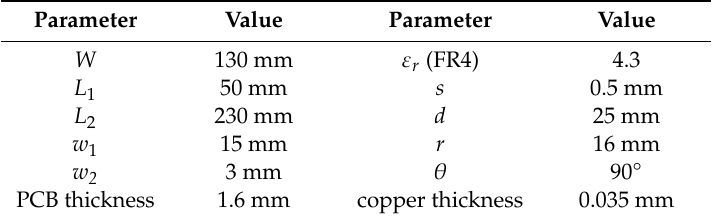
Table 1. Dimensions of Tx and Rx Vivaldi antennas for S-band frequency (2–4 GHz).